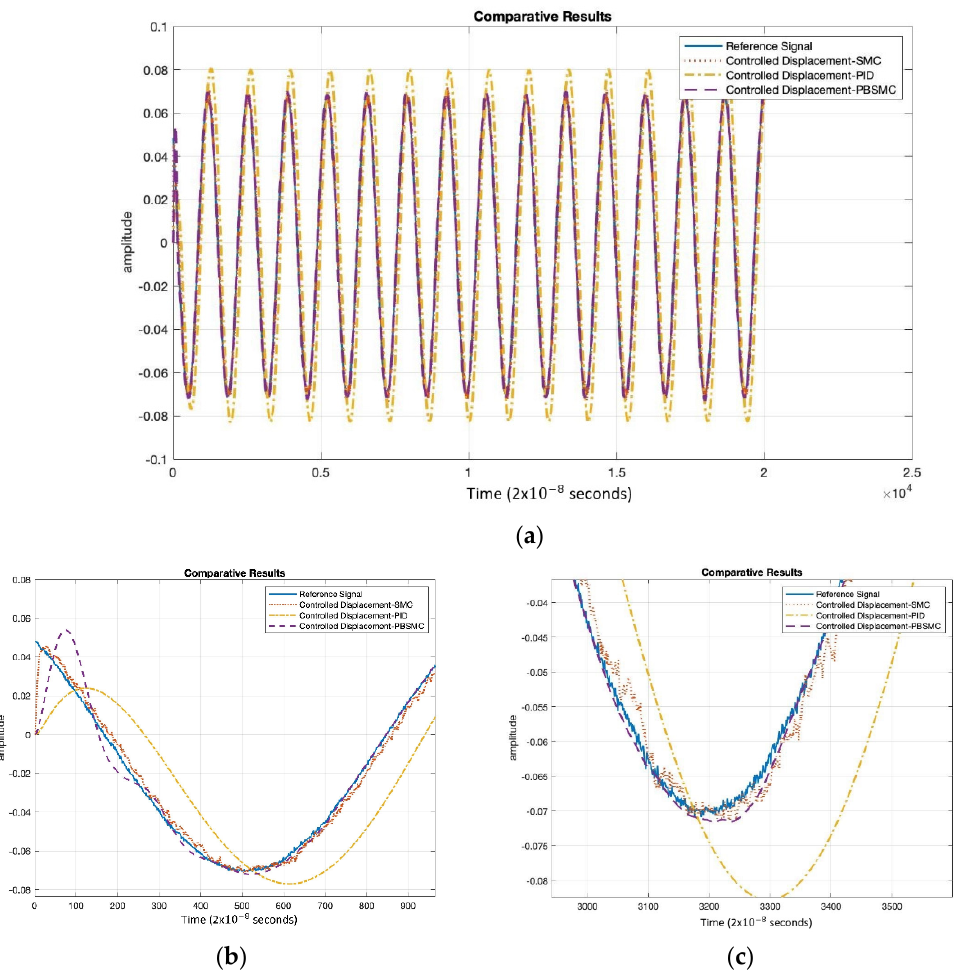
Figure 11. ( a ) Experimental Controller Tracking Performance Comparison, ( b ) Initial Oscillations, ( c ) Steady-State Tracking Performance.